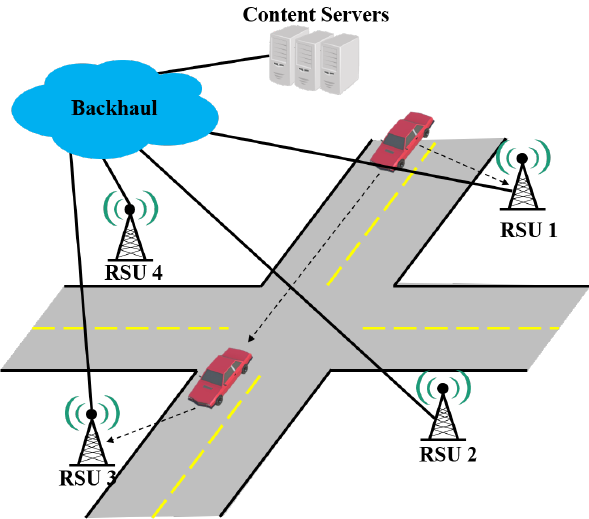
Figure 1. Overview of the proposed strategy on content-centric vehicular